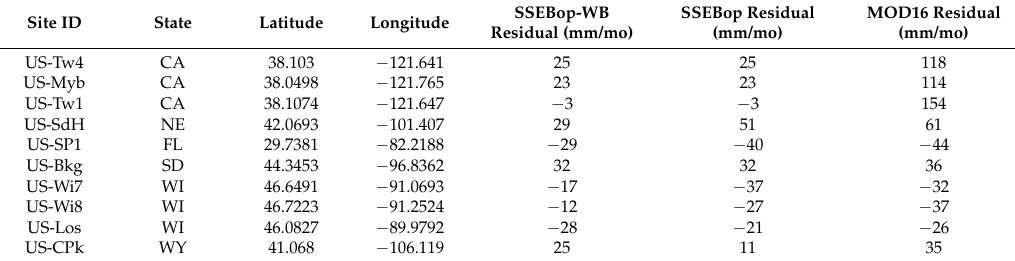
Table 4. AmeriFlux sites with the highest average magnitude difference compared with remote sensing ET data sets, listed in descending order for the new SSEBop-WB data set, the SSEBop ET, and the MOD16 ET.